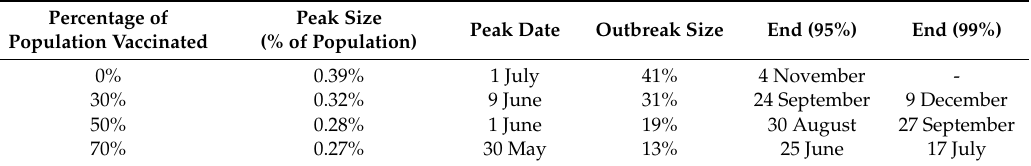
Figure 9. Epidemic curves of multiple vaccination scenarios. Curves are smoothed using a Savitzky-Golay filter [79] (filter with a window length of 31 and a degree 3 polynomial). Table 5. Epidemic curves of multiple vaccination scenarios.